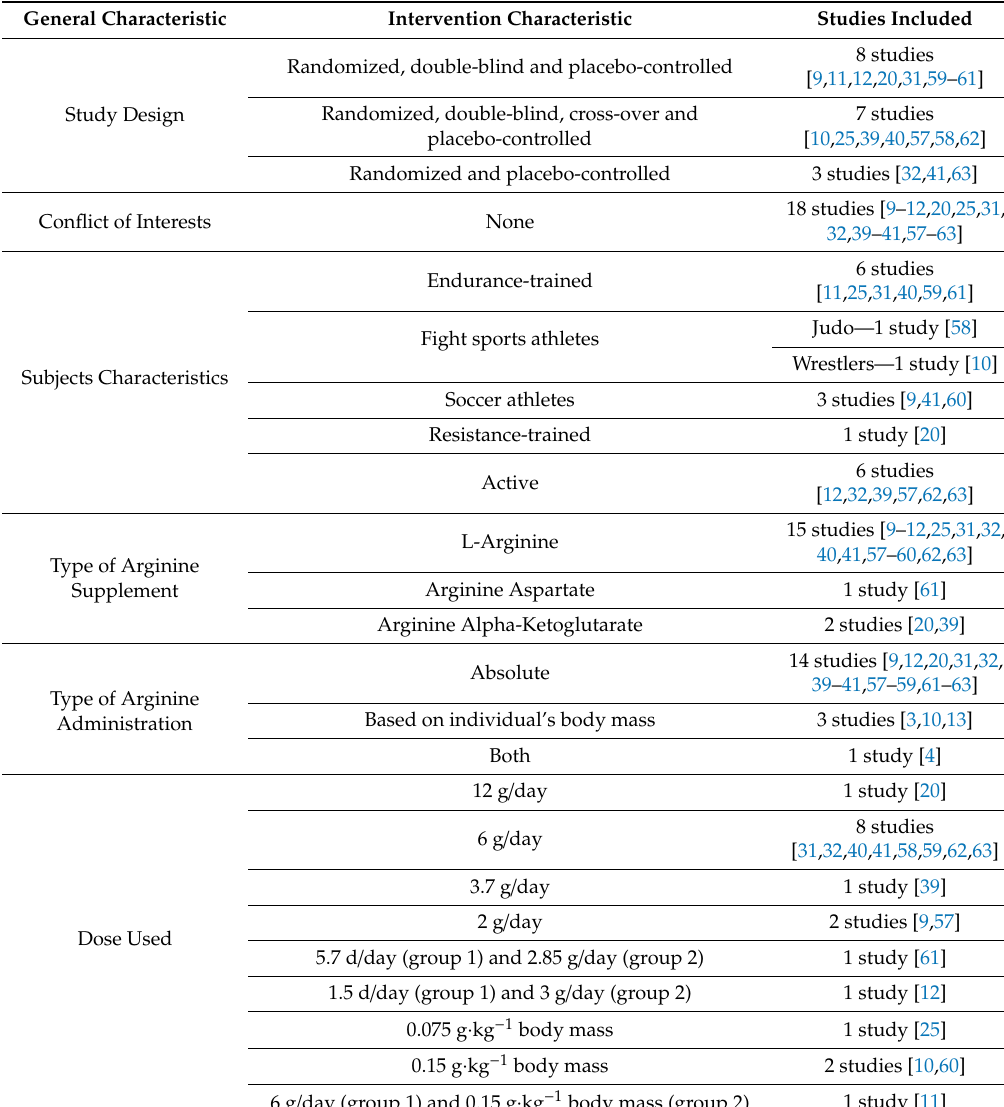
Table 1. Participant and intervention characteristics of the studies included in the systematic review and